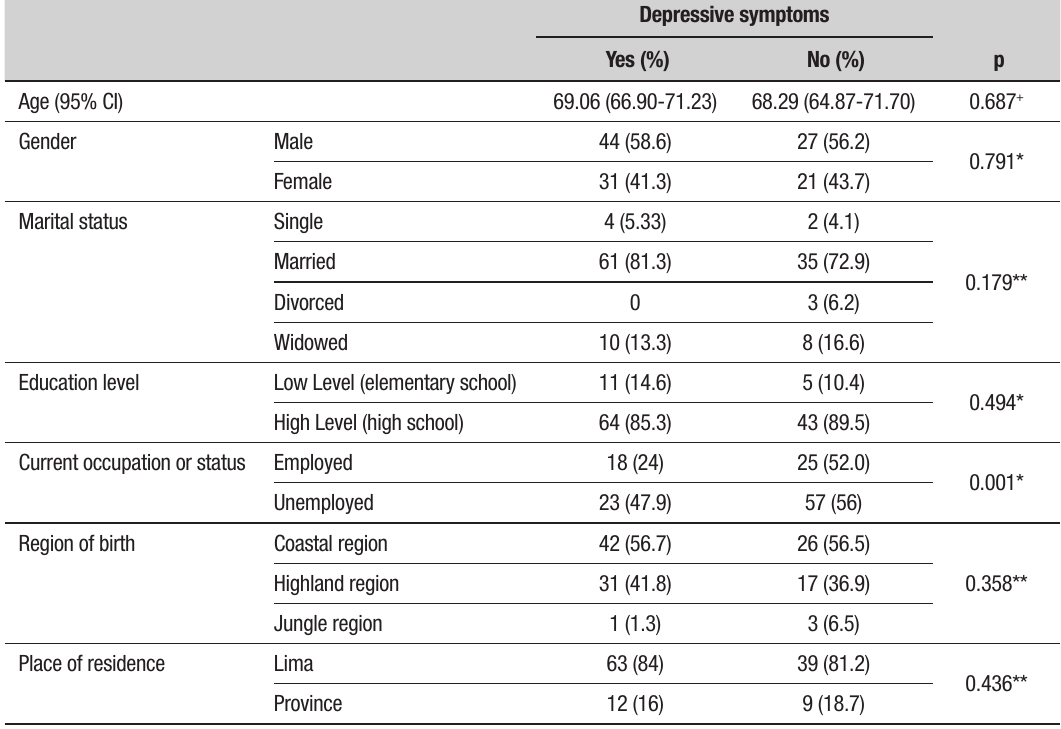
Table 2. Epidemiological characteristics in patients with